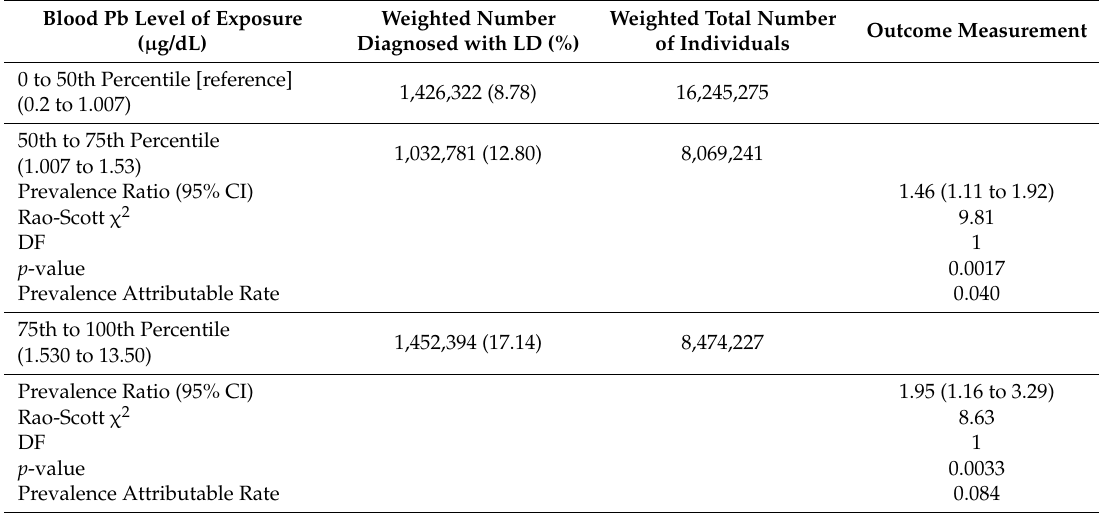
Table 3. A summary of survey frequency modeling 1 to evaluate the potential relationship between increasing blood Pb levels and the risk of learning